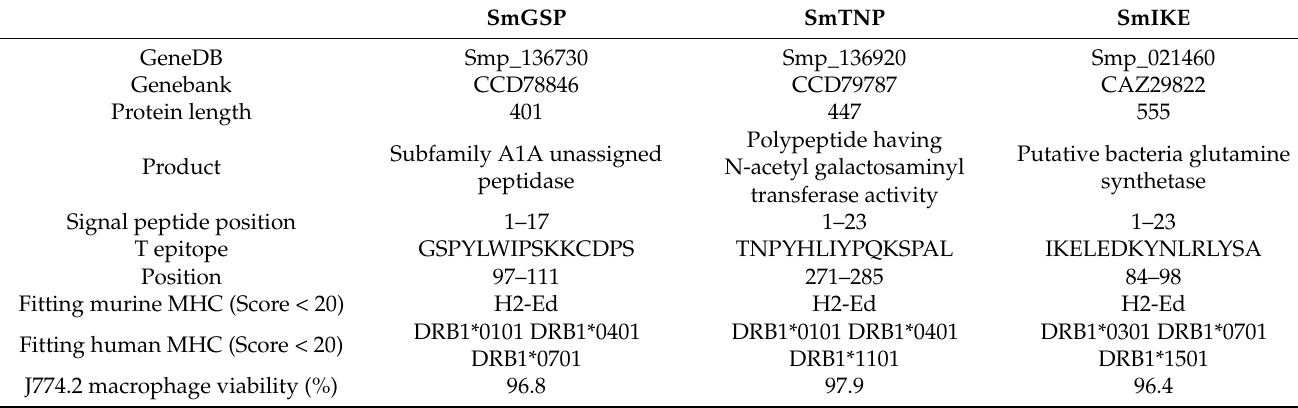
Table 1. Characterization of the peptides selected as vaccine candidates from highly expressed proteins in cercaria to 3-h schistosomulum with highly potential host–parasite interaction. Signal peptides were predicted by SignalP 4.1 and T cell peptides fitting human and mouse alleles by SYFPEITHI. Peptides’ potential cytotoxicity was measured as the percentage of J774.2 macrophage viability by the third day of